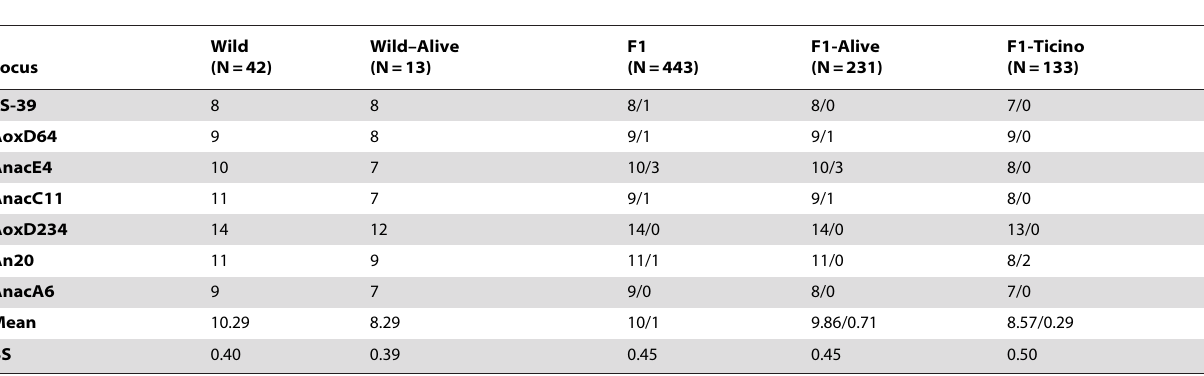
Table 2. Number of alleles per locus in the different stocks and average band sharing (BS) values at 7 microsatellite loci.